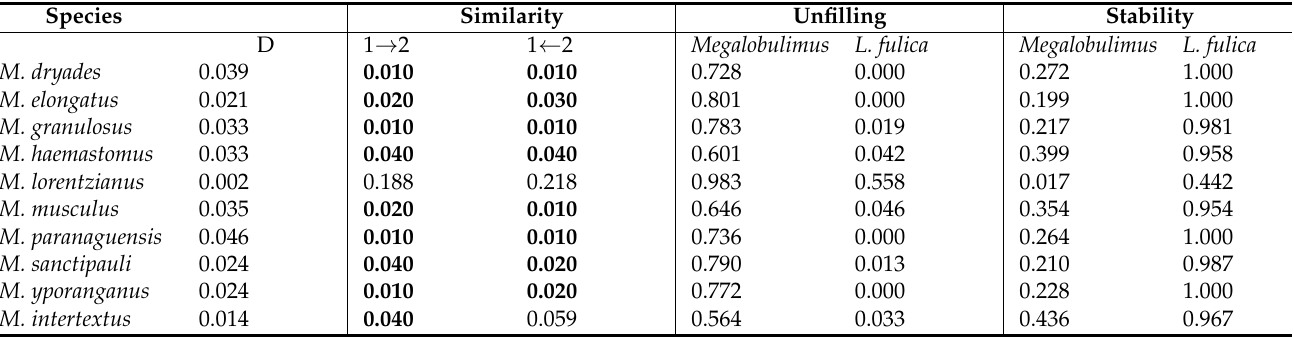
Figure 5. Potential species richness distribution of Megalobulimus species in the current and future scenarios. Locations with low species richness are shown in blue, whereas locations with high species richness are shown in red. The potential distribution of Lissachatina fulica in both scenarios is hatched. Table 3. Results of niche overlap comparison between Lissachatina fulica and Megalobulimus species. Significant p -values of the similarity test are shown in